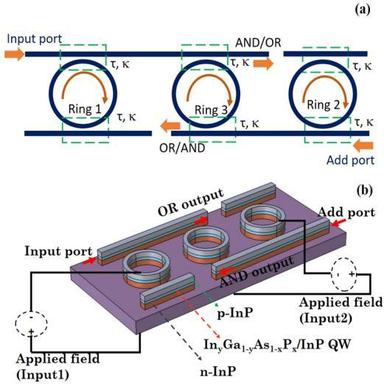
(a) Parallel triple ring MRR configuration for OR and AND gate realization. (b) Perspective view of OR AND gate based on EA MRR.